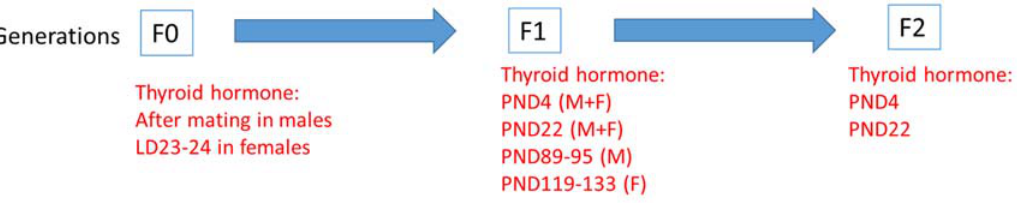
Figure 2. Simplified overview of the experimental design of the EOGRTS: TH measurements [44]. PND: postnatal day; LD: lactating day, M: males; F: females.